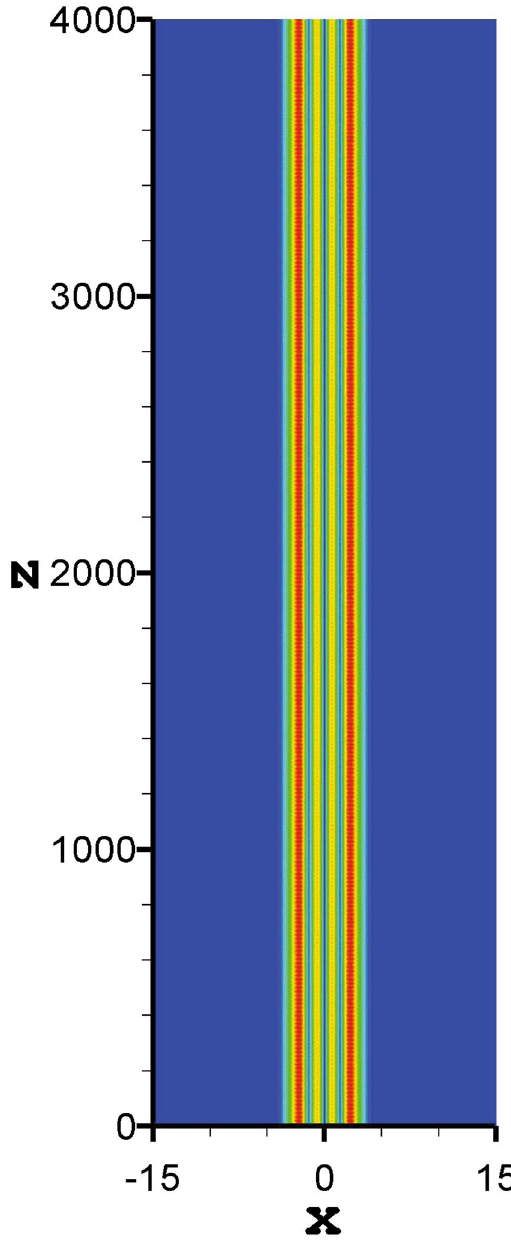
Figure 11. Propagation of quadrupole-mode solitons in the presence of 1% white input noise. The parameters are taken from Fig.